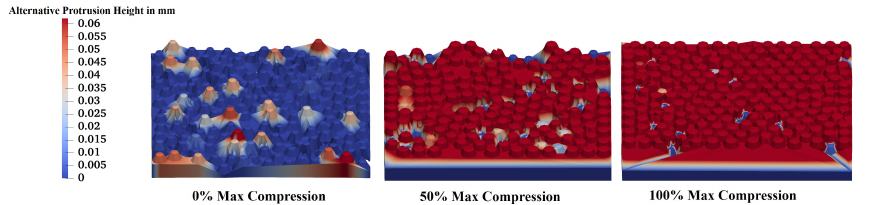
Figure 39. Grit 80 ( d mean = 0.165 mm) surface topography with alternative protrusion height at 0%, 50%, and 100% maximum